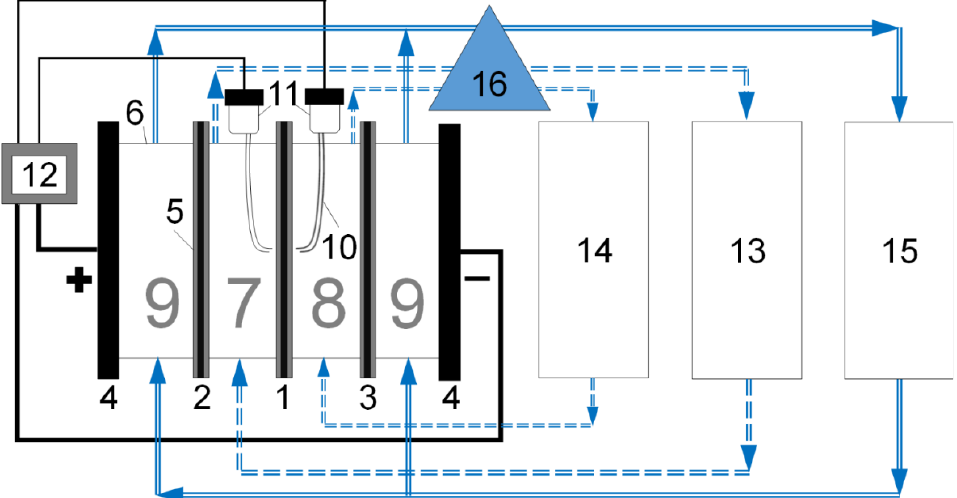
Figure 2. Scheme of the electrodialysis cell in the variant used for electrodialysis. The studied membrane is shown as 1, 2 and 3 are the auxiliary anion exchange and cation exchange membranes, respectively, 4 are the polarizing electrodes attached to the plexiglass plate, 5 is a rubber o-ring, 0.075 cm thick in assembled state, 6 is a plexiglass frame 0.5 cm thick, 7 is the desalination chamber, 8 is the concentration chamber, 9 are the electrode chambers, 10 is a Luggin capillary, 11 are the Ag/AgCl electrodes, 12 are the power source and a multimeter, 13 is the circulation tank of a desalination tract, 14 is the circulation tank of a concentration tract, 15 is the circulation tank of electrode tract, 16 is the multichannel pump. The figure is reproduced from our previous article [39].